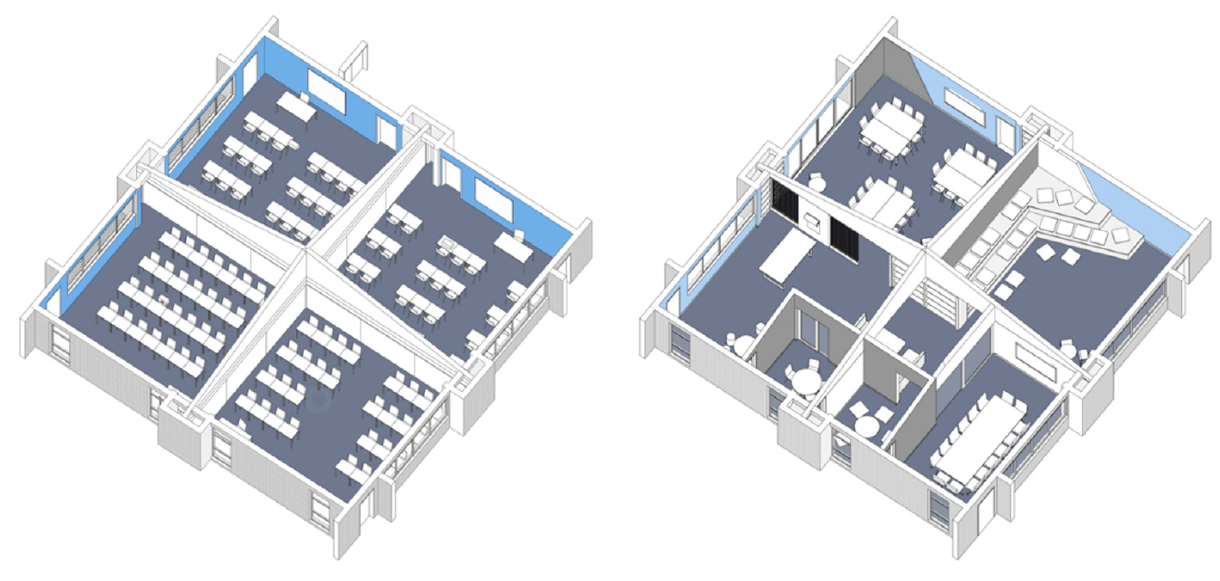
Figure 1. Before and after floor plans of a re-developed learning space, a school in Sydney, Australia (Image courtesy of Hayball architects) [42].